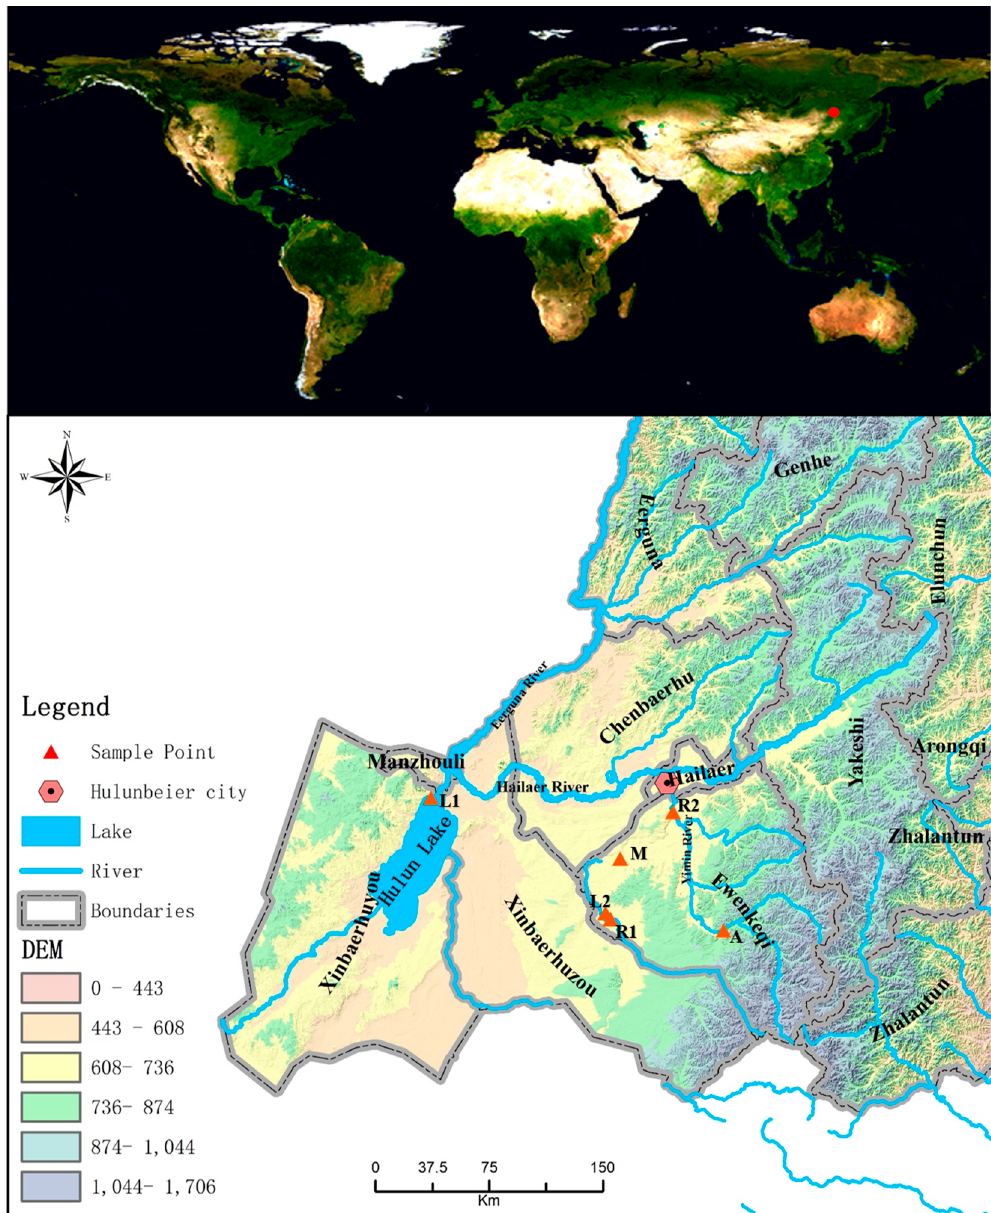
Figure 1. Location of the steppe wetland and distribution of sampling points.